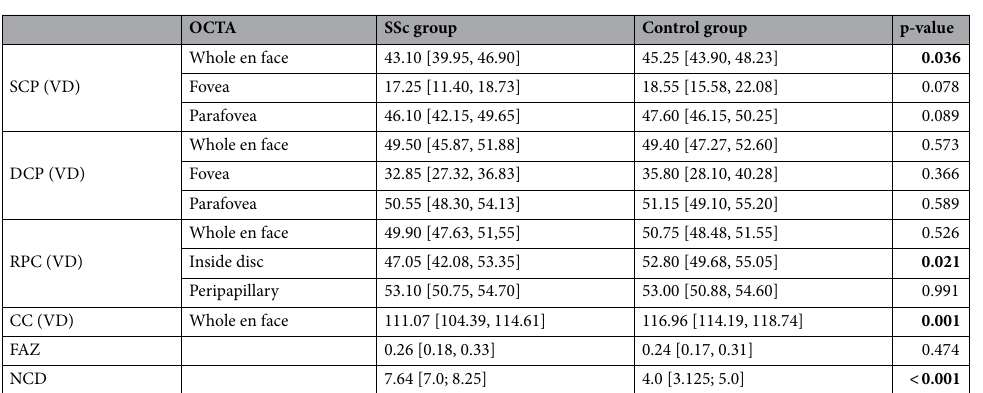
Table 2. Vessel density (VD, %) of the SSc group and control group obtained in the regions indicated [superficial retinal capillary plexus (SCP), deep retinal capillary plexus (DCP), choriocapillaris (CC) and optic nerve head capillary density (RPC)], as well as the foveal avascular zone area (FAZ) in mm 2 and nailfold capillary density (NCD) per millimeter. Data are presented as median [25th, 75th percentile]. A Mann– Whitney-U-test was used to compare both groups. Bold: statistically significant